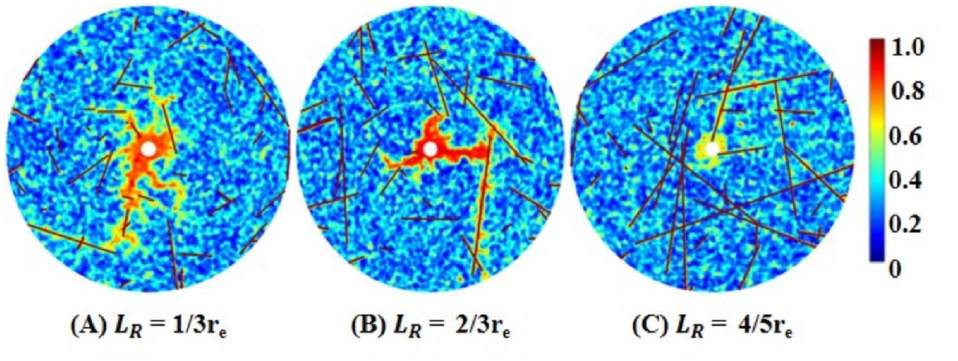
Figure 4. Effect of fracture length on wormhole structures in radial acidizing